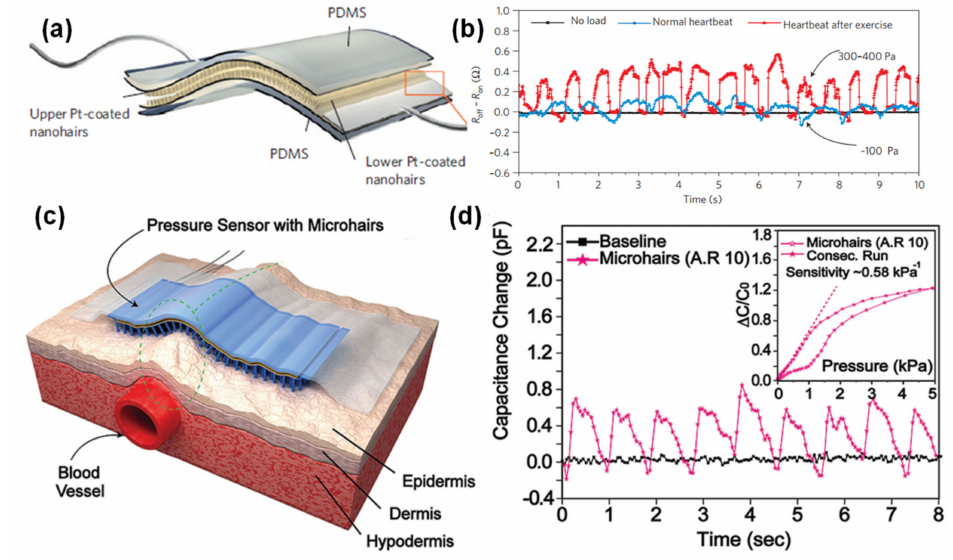
Figure 12. E-skins applied to heartbeat. ( a ) E-skin developed by Kahp-Yang Suh and co-workers in 2012 [131] (Copyright © 2020, Springer Nature). ( b ) Output of the e-skin in (a) during resting or after exercise [131] (Copyright © 2020, Springer Nature). ( c ) Schematic illustration of the e-skin developed by Zhenan Bao and co-workers in 2015 [165] (Copyright © 2020 WILEY-VCH Verlag GmbH & Co. KGaA, Weinheim, Germany). ( d ) Radial artery pulse wave detected by an e-skin in (c), with microhairs with an aspect ratio of 10; the inset shows the sensitivity of the e-skin [165] (Copyright © 2020 WILEY-VCH Verlag GmbH & Co. KGaA, Weinheim,